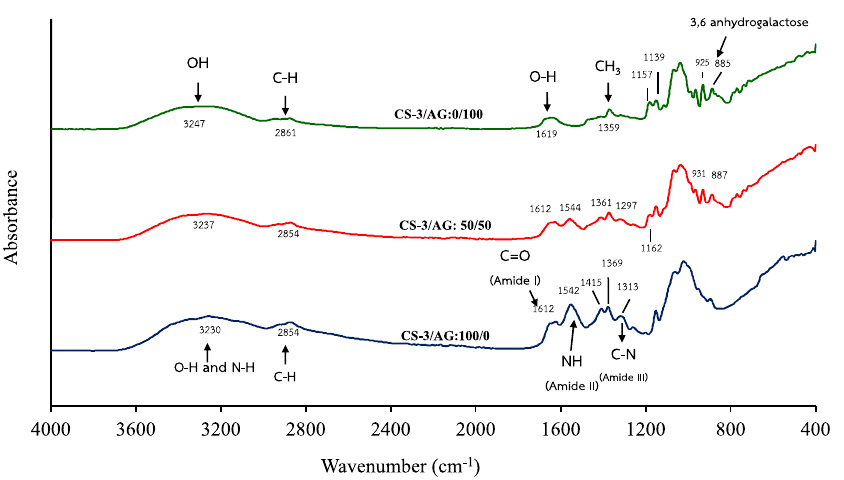
Figure 2. ATR − FTIR spectra of the selected CS − 3/AG composite films with various ratios (100/0, 50/50 and 0/100).